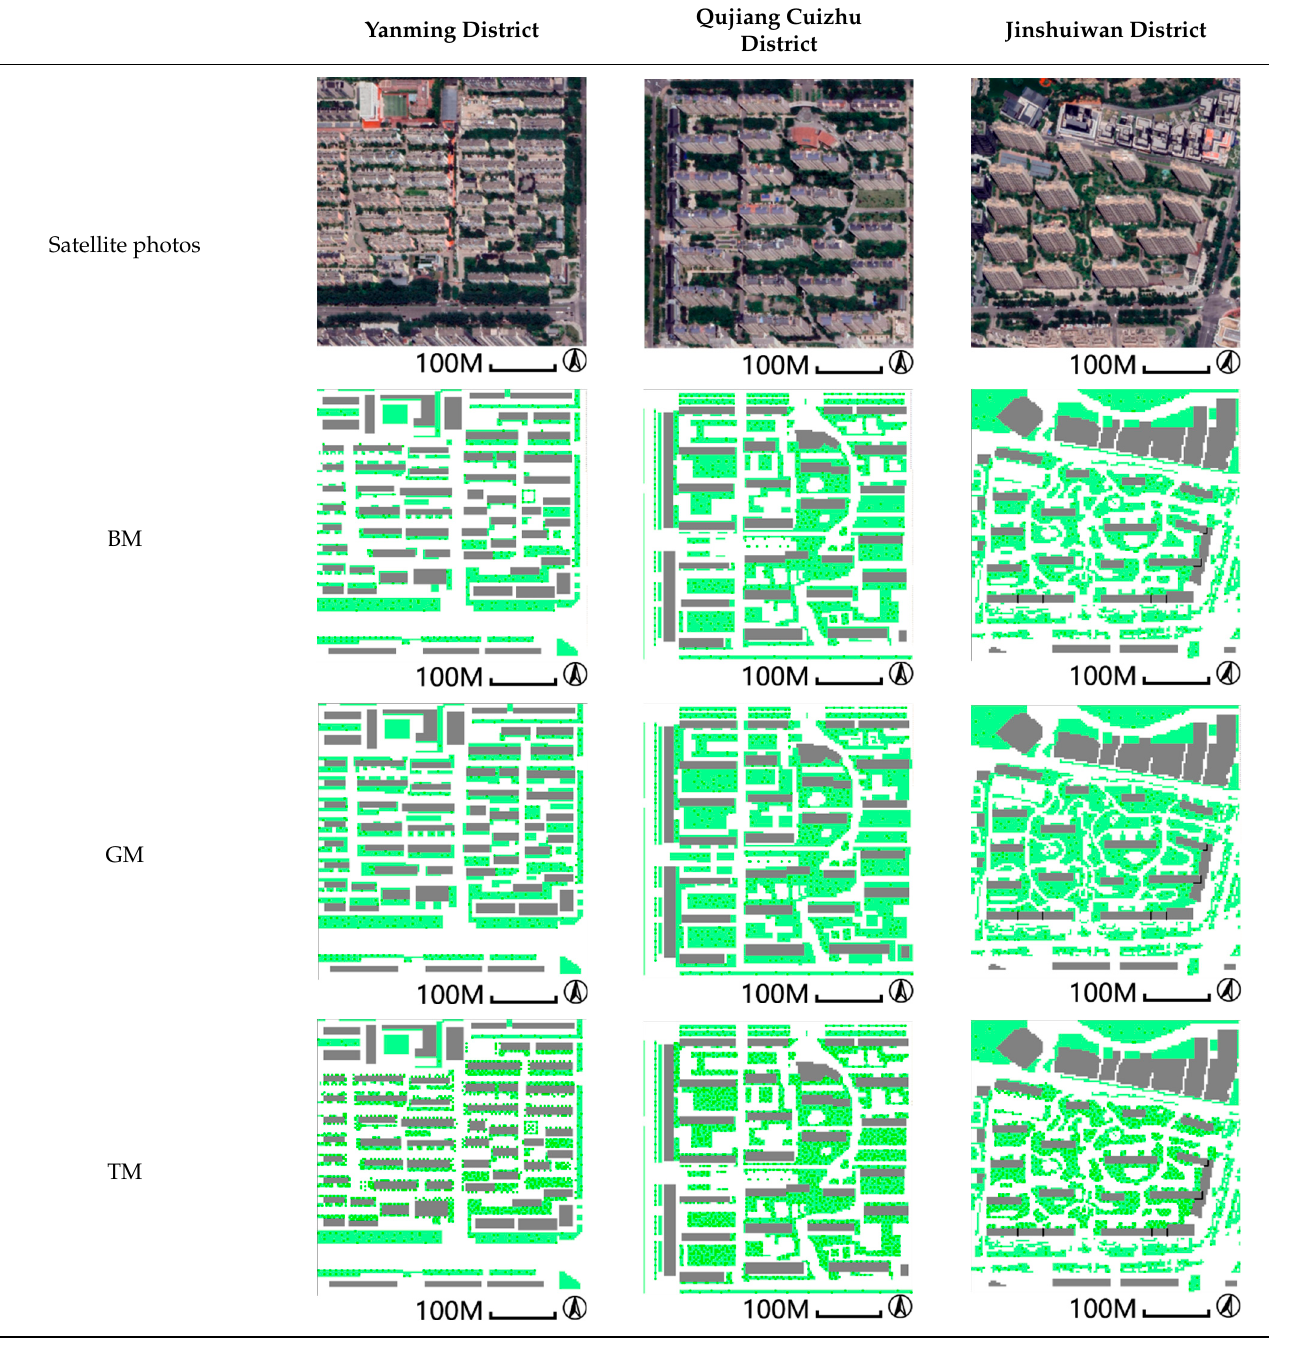
Table 2. The satellite photos, BM, GM, and TM of three selected districts.